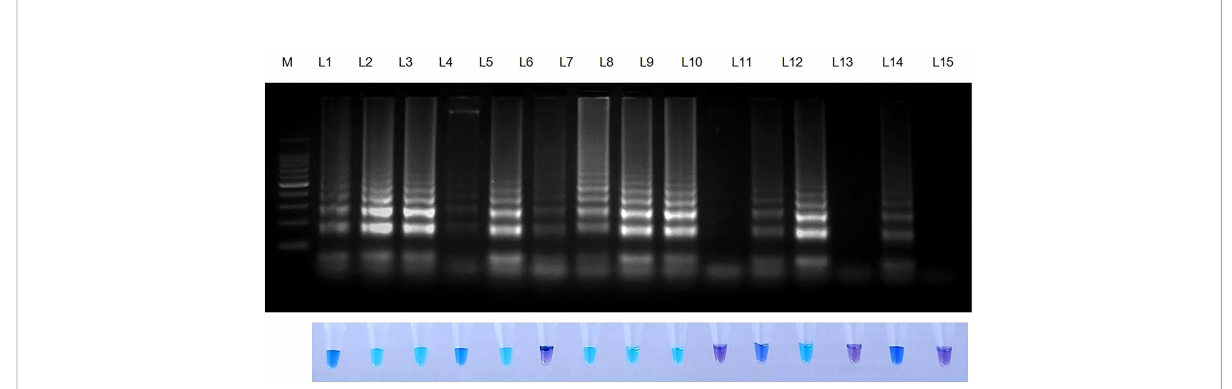
FIGURE 7 Validation of LAMP assay with naturally infected seeds of different varieties. Bright sky blue colour represents positive reaction while the violet colour indicates the negative reaction. Upper panel in the fi gure shows agarose gel electrophoresis results whereas lower panel shows reaction tubes for colorimetric detection. M- 100bp Ladder; Lane 1: Sarocladium oryzae isolate OM841519 (Positive control); Lane 2: Co 39; Lane 3: Co 51; Lane 4: Co 52; Lane 5: Co 53; Lane 6: Co 54; Lane 7: Co 55; Lane 8: ADT 37; Lane 9: ADT 43; Lane 10: RNR 15048; Lane11: TN 1; Lane